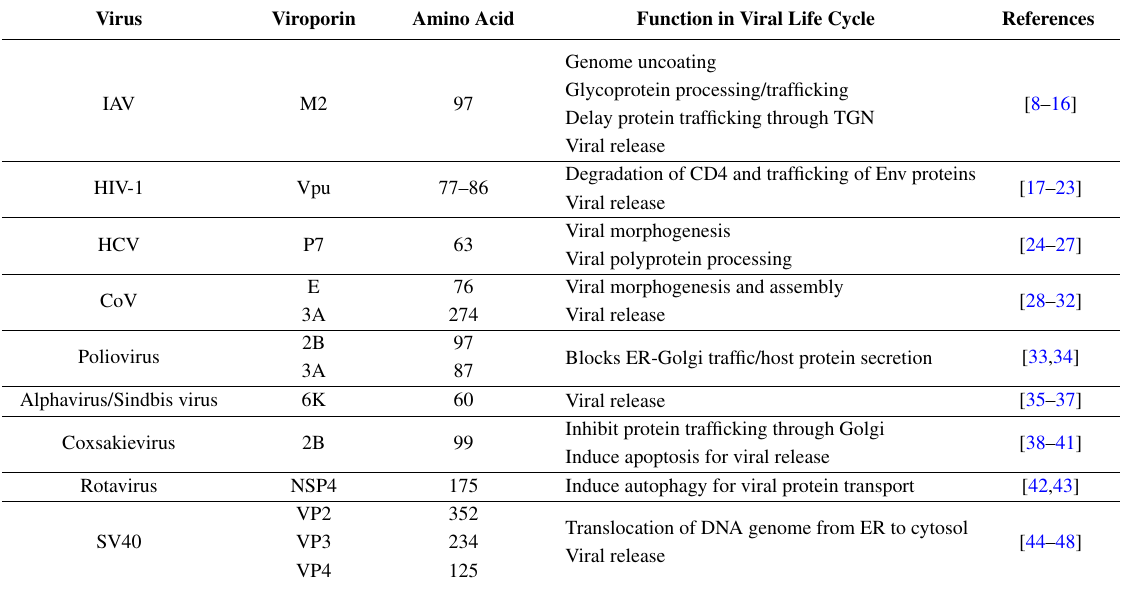
Table 1. List of known viroporins and their known function in viral life